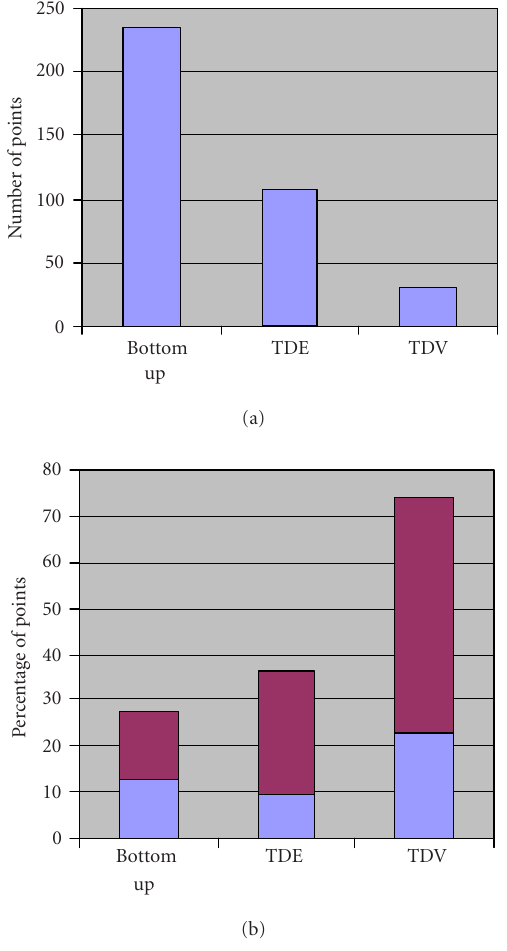
Figure 5: (a) Evolution of the number of points explored by the system in the three investigated modes. (b) Evolution of the ratio between faces and nonfaces in the visited points (upper values) and evolution of the recognition error rate (lower